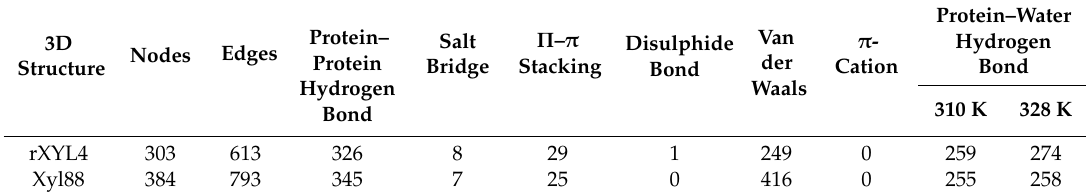
Table 3. The number of di ff erent interactions in rXYL4 and